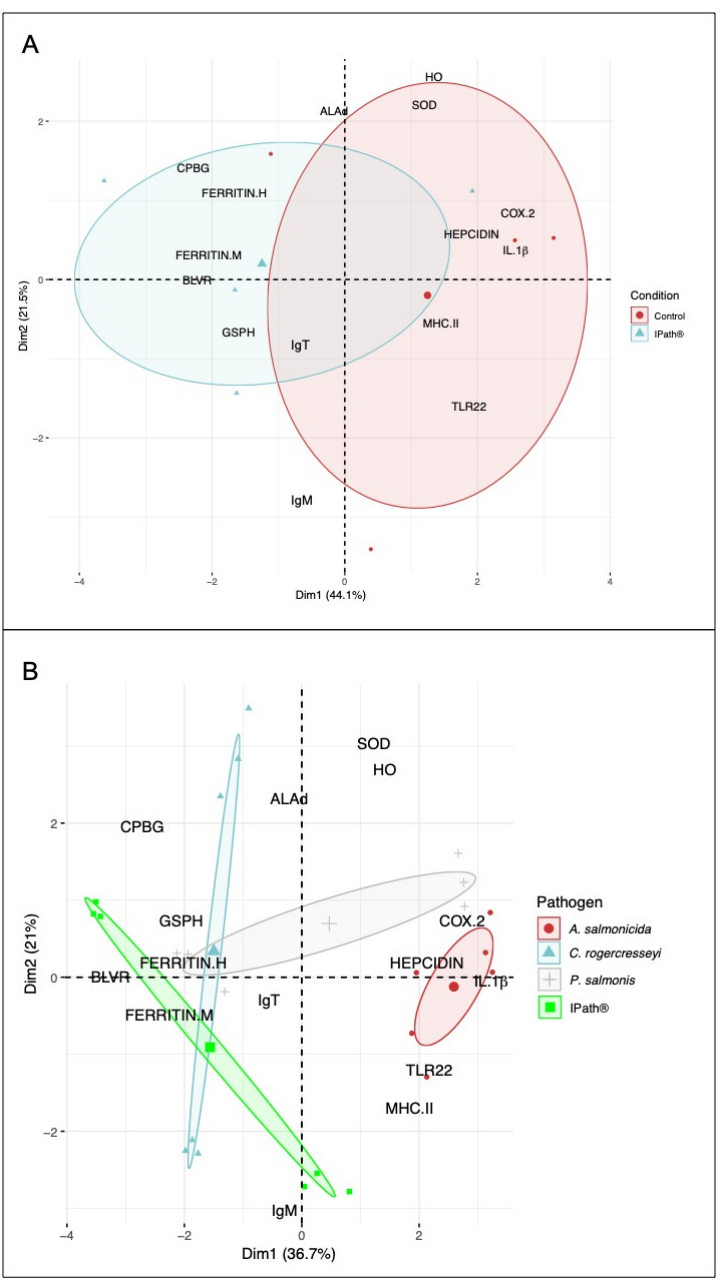
Figure 6. Principal component analysis for transcription expression of iron-homeostasis- and immune-related genes in Atlantic salmon. ( A ) Biplot based on experimental groups (e.g., IPath ® vaccine vs. control group) as a factor for gene expression differences. ( B ) Biplot based on pathogen challenge (e.g., A. salmonis infection, C. rogercresseyi infection, P. salmonis infection) as a factor for gene expression differences. Both biplots were constructed based on gene expression analyses obtained by qPCR